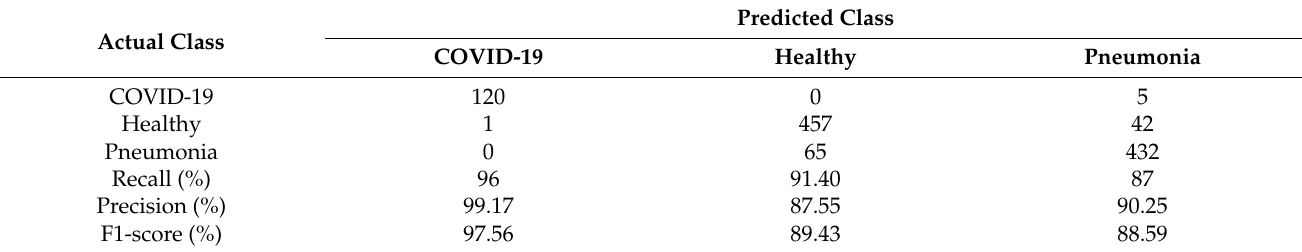
Table 4. Results obtained using our proposed Exemplar COVID-19FclNet9 model with DB2 database. Actual Class